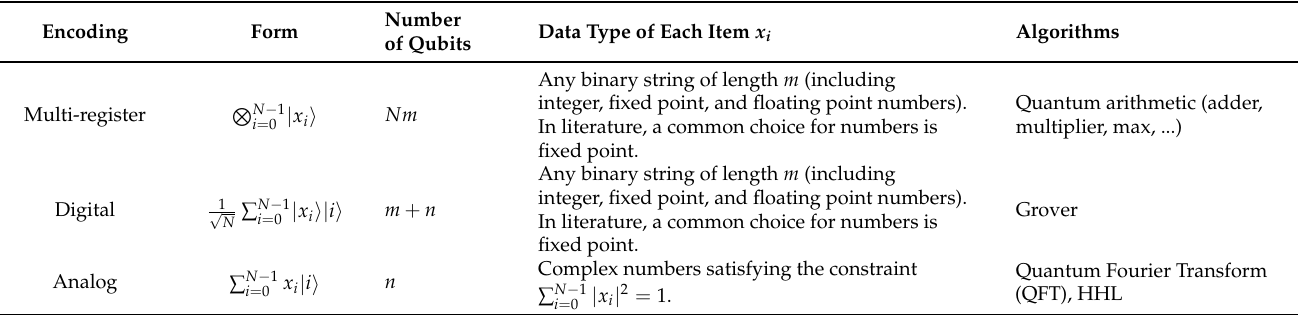
Table 1. Three different ways to encode the data set the number of qubits needed for the